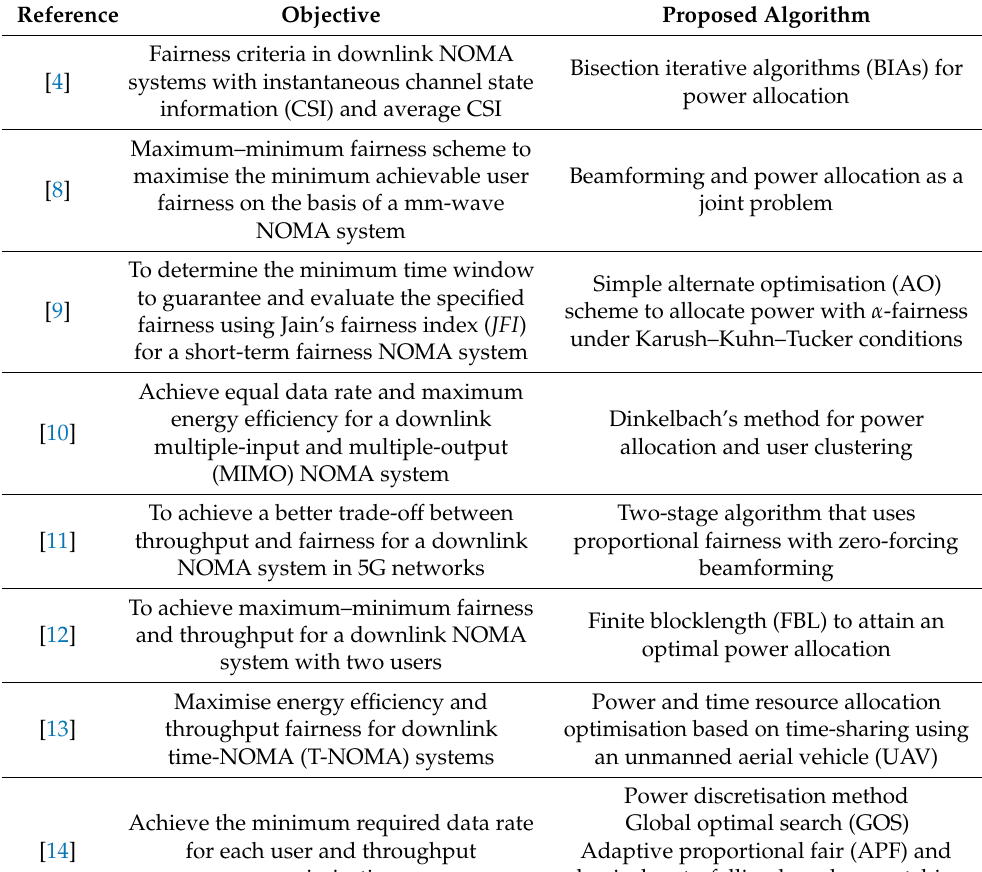
Table 1. Summary of the literature